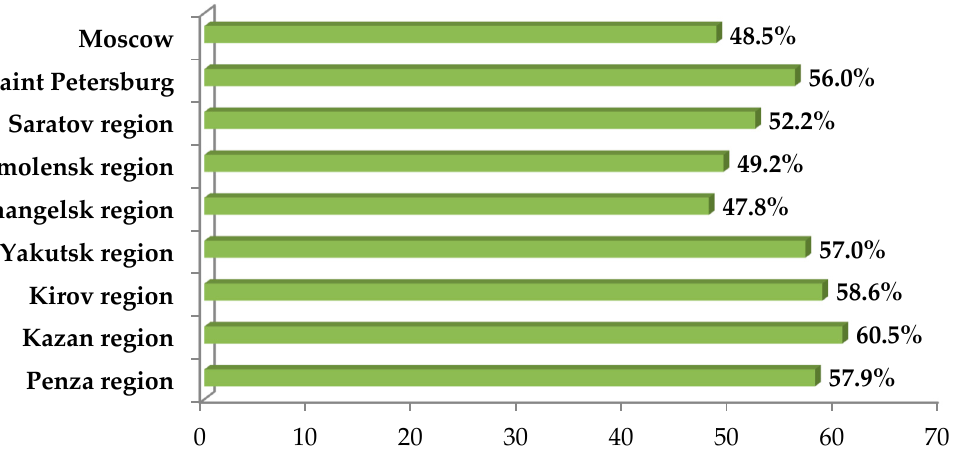
Figure 6. Vaccination coverage of the populations of the studied regions at the time of the study.